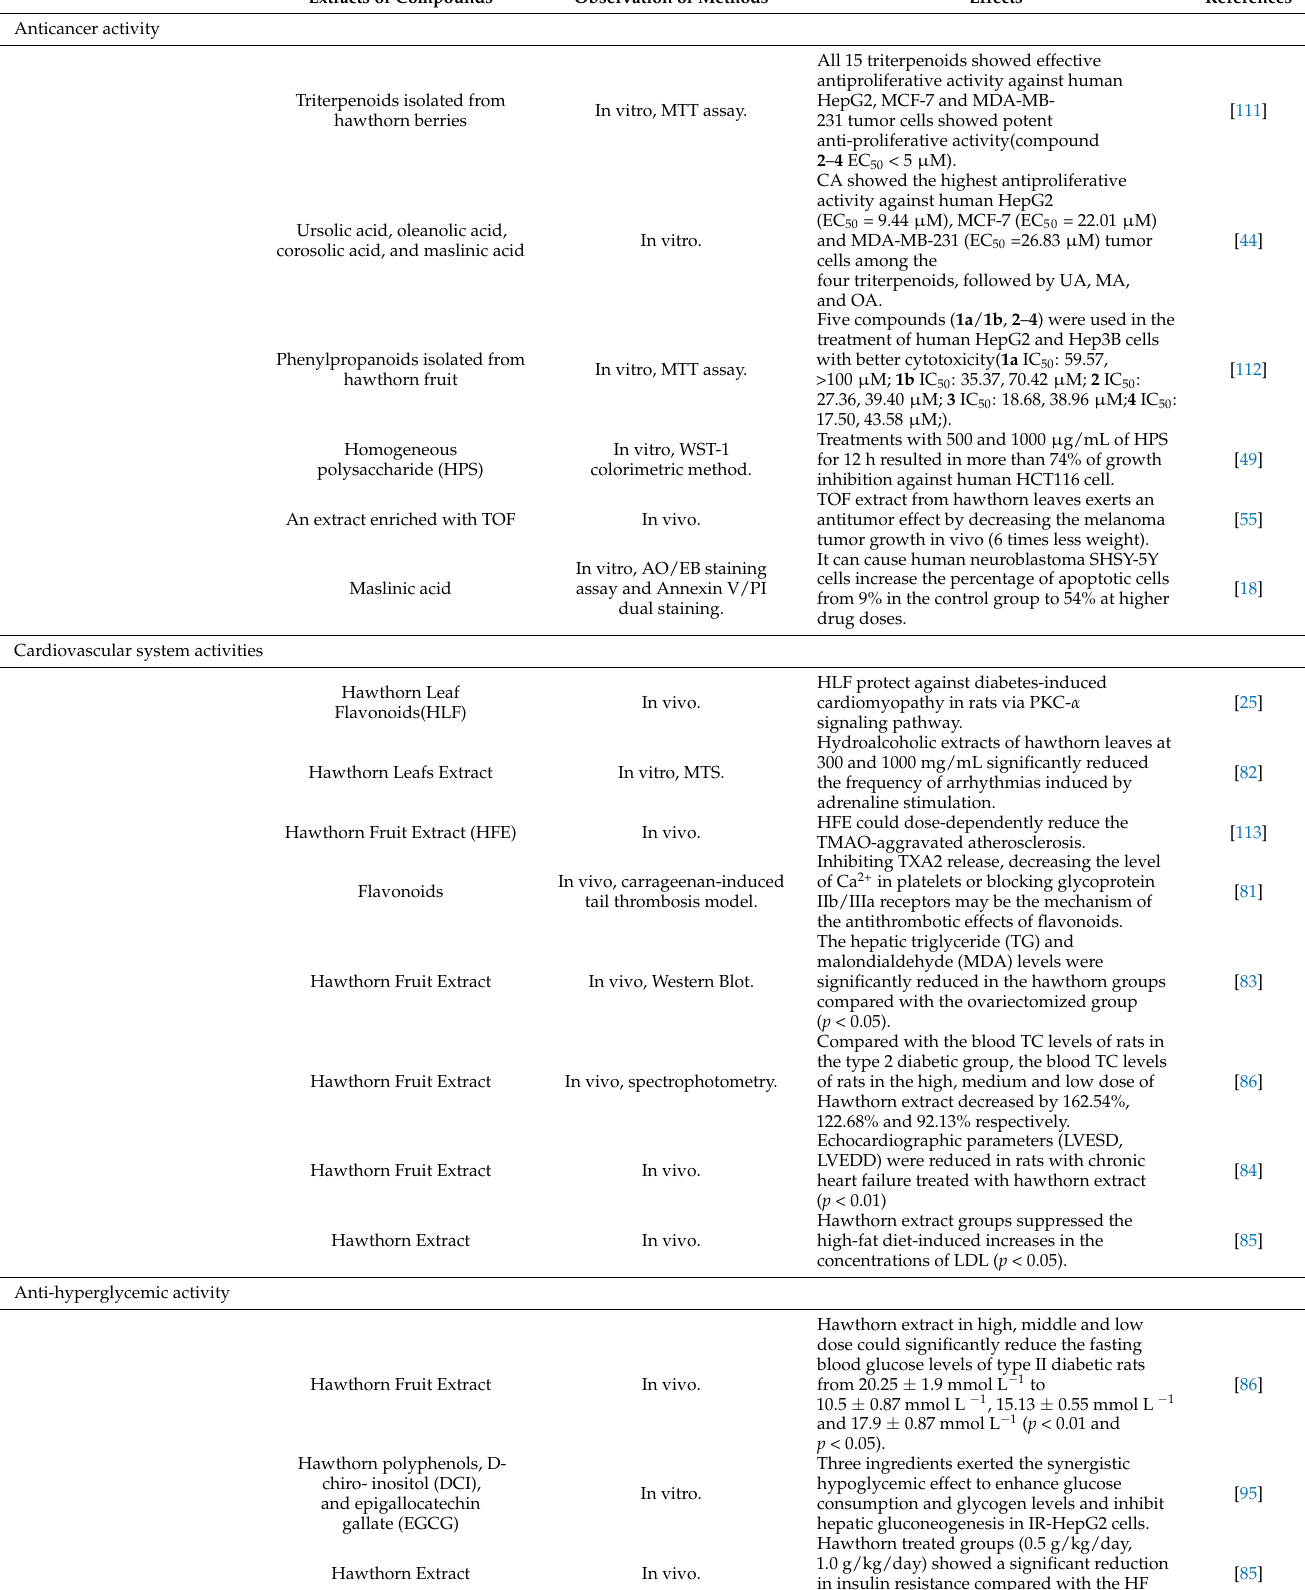
Table 4. Biological activity and mechanism of action of